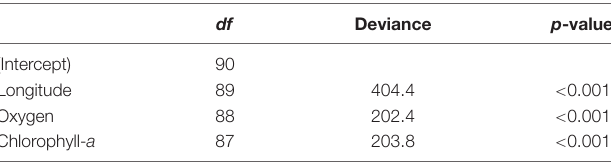
TABLE 4 | Analysis of deviance testing the effect of each predictor considered in the multivariate GLM to model echinoderm assemblage composition. df Deviance p